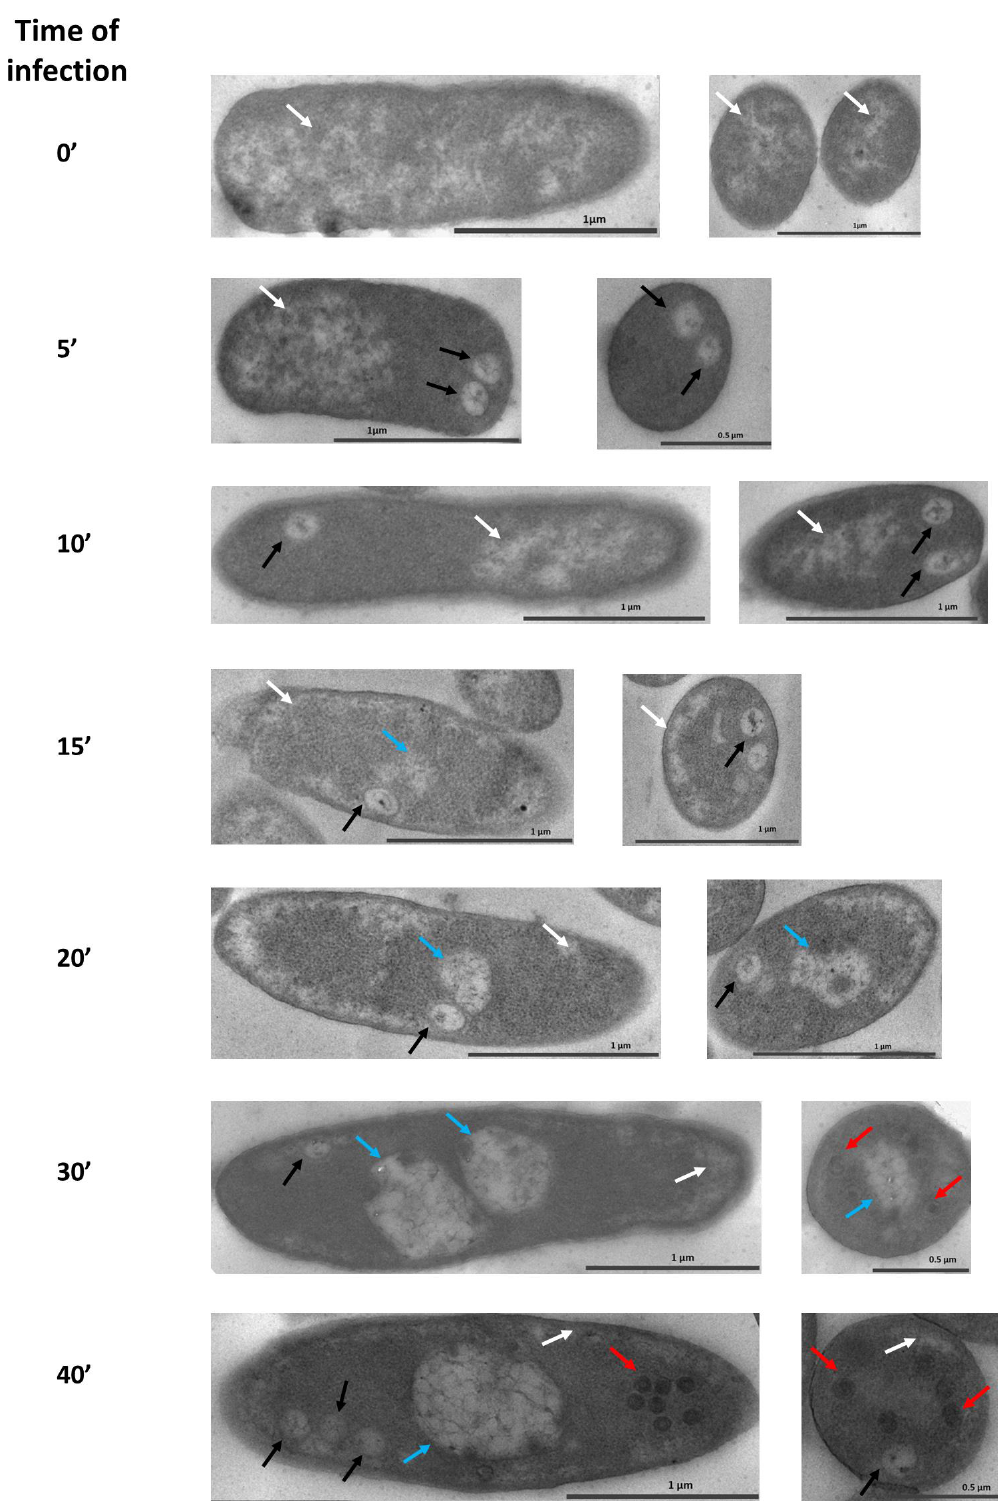
Figure 1. Time-course of the phiKZ infection and pseudo-nucleus maturation in P. aeruginosa cells. Left column — minutes after infection. White arrows — bacterial nucleoid; black arrows — round compartments (RC); blue arrows — pseudo-nuclei at different stages of maturation; red arrows — new phage capsids.